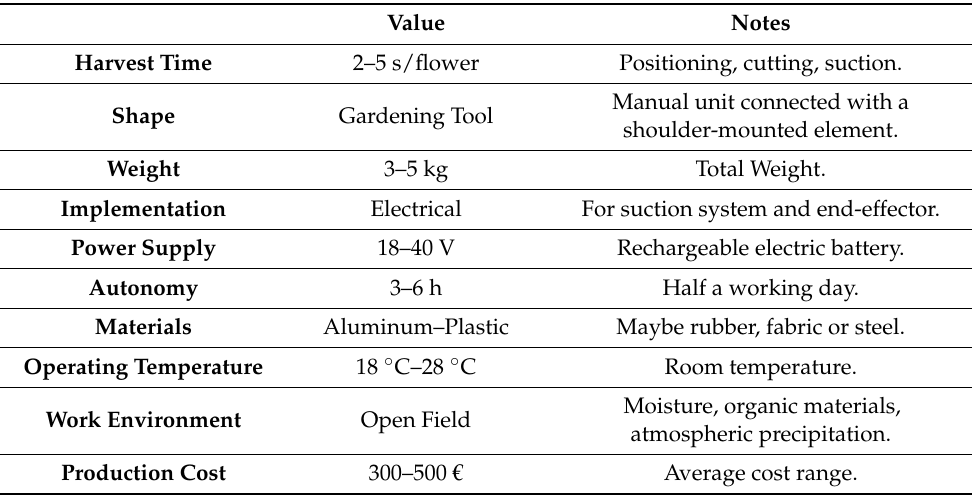
Table 2. Technical specifications of the proposed